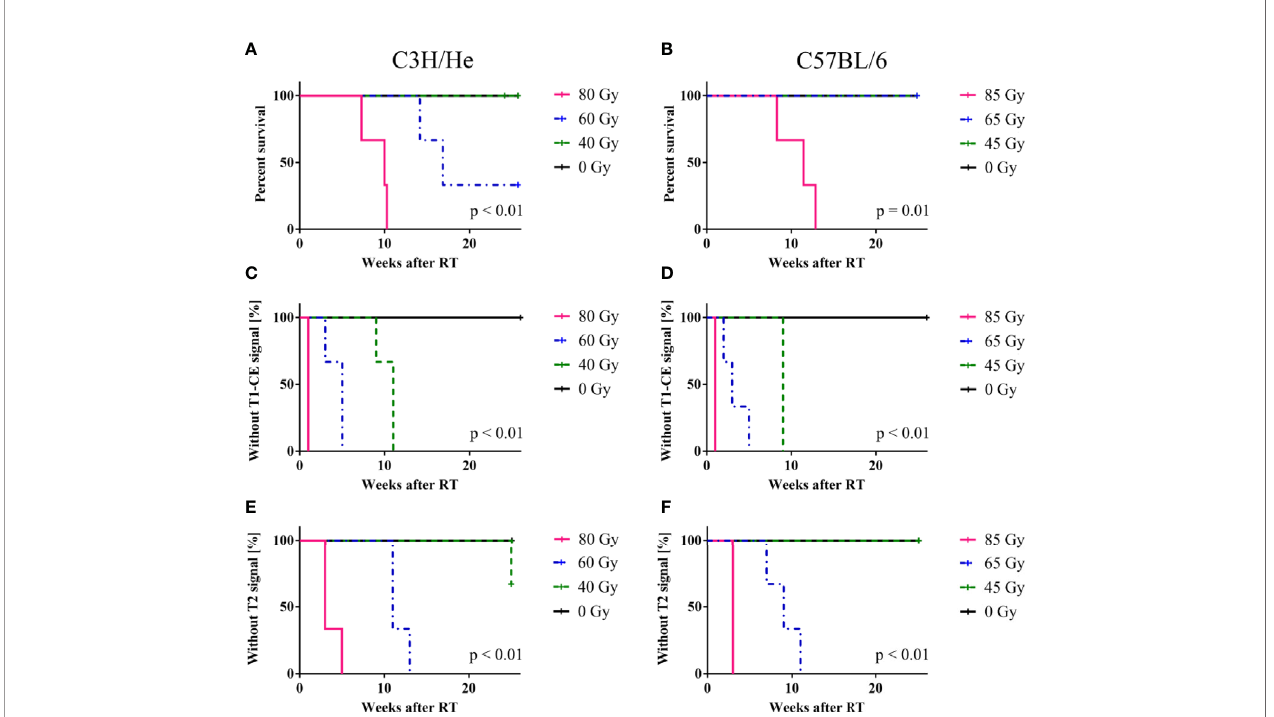
FIGURE 4 | Mouse survival, onset of CE in T1w and signal onset in T2w MRI. (A, B) C57BL/6 mice showed an increased survival rate compared to C3H/He, whereas (C – F) onset times of MR image changes exhibited a similar pattern in both mouse strains, with a clear dose-dependency. T2w signal only appeared after T1w CE was observed. The log-rank test indicates that there is a signi fi cant difference in survival and signal onset in MRI between the dose